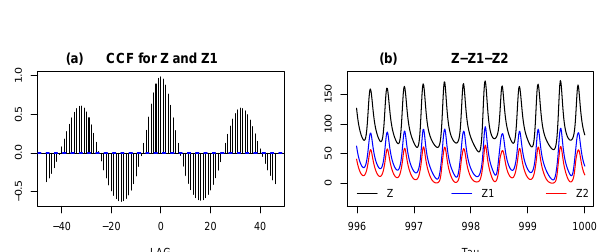
Figure 9. Scatter plots for the 5DLM and 7DLM with r = 120. The results indicate that the correlation coefficients become larger in the 7DLM than in the 5DLM.